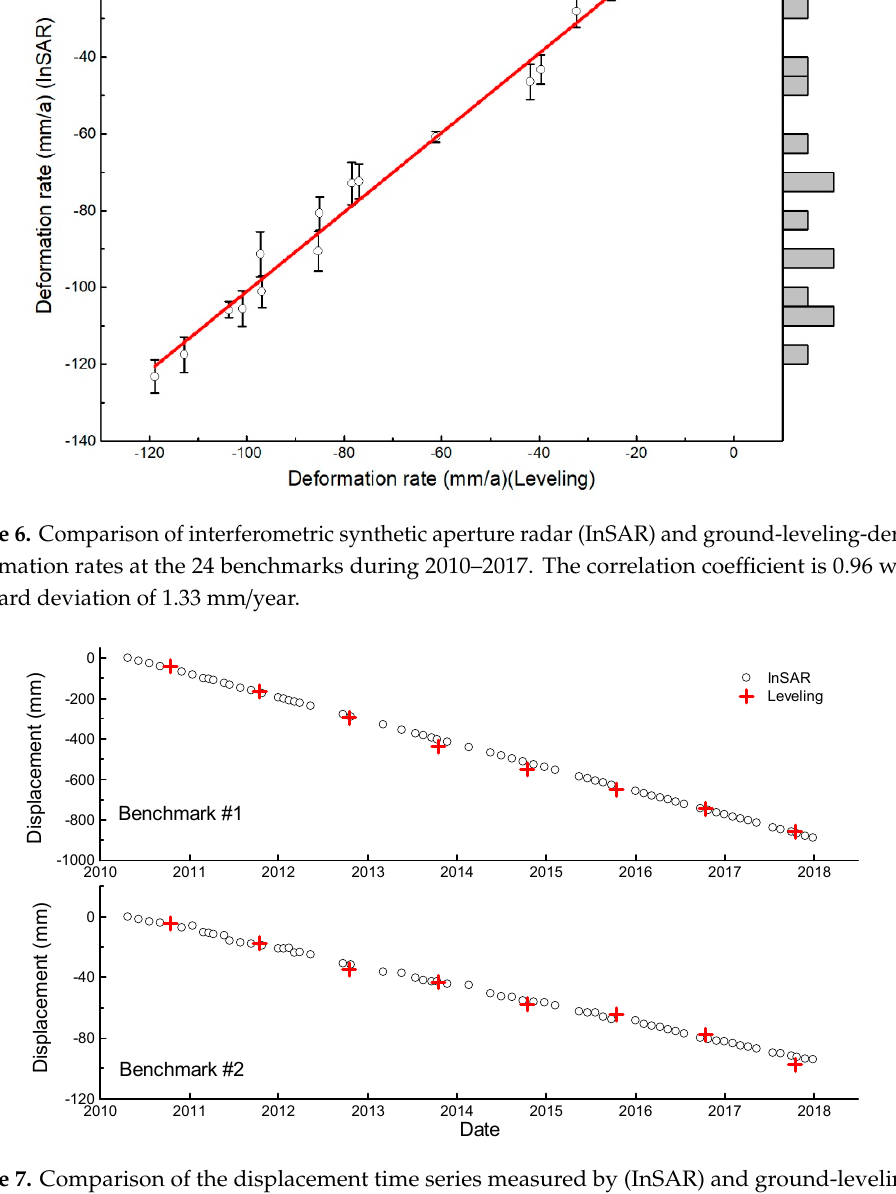
Figure 7. Comparison of the displacement time series measured by (InSAR) and ground-leveling at benchmarks #1 and #2.